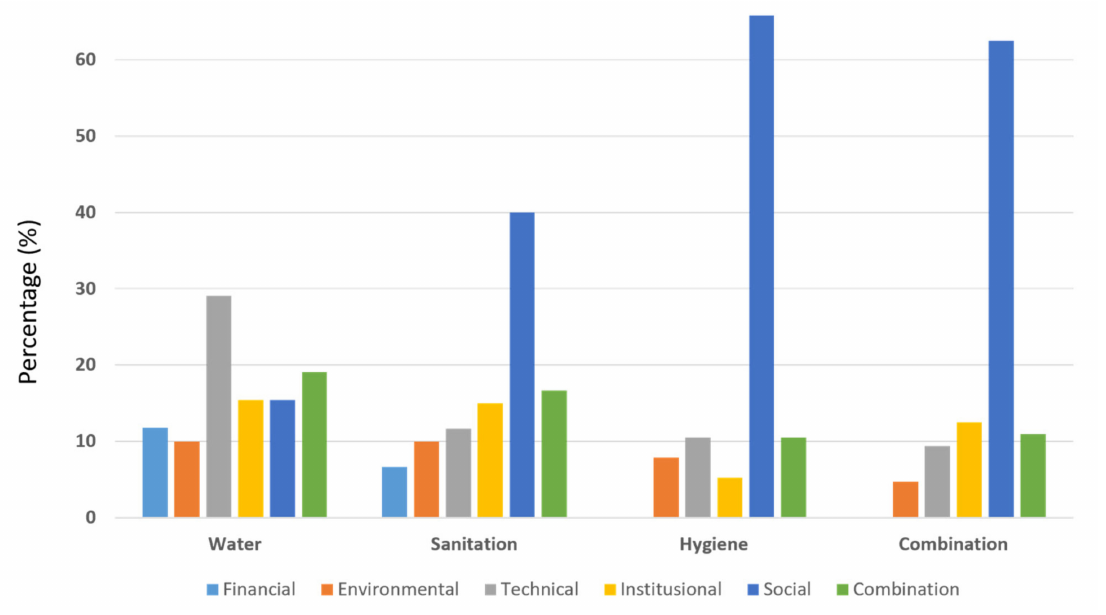
Figure 2. ( a ) Proportion of research topics and ( b ) Proportion of themes.